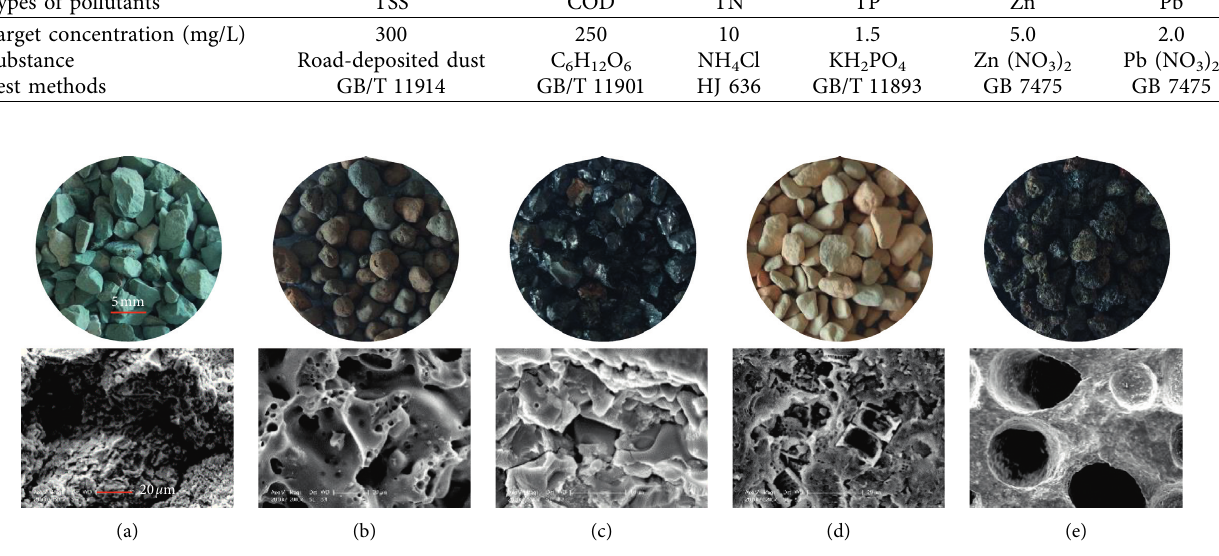
Figure 3: Surface morphologies and microstructures of the selected filter media. (a) Zeolite. (b) Ceramsite. (c) Slag. (d) Diatomite. (e)